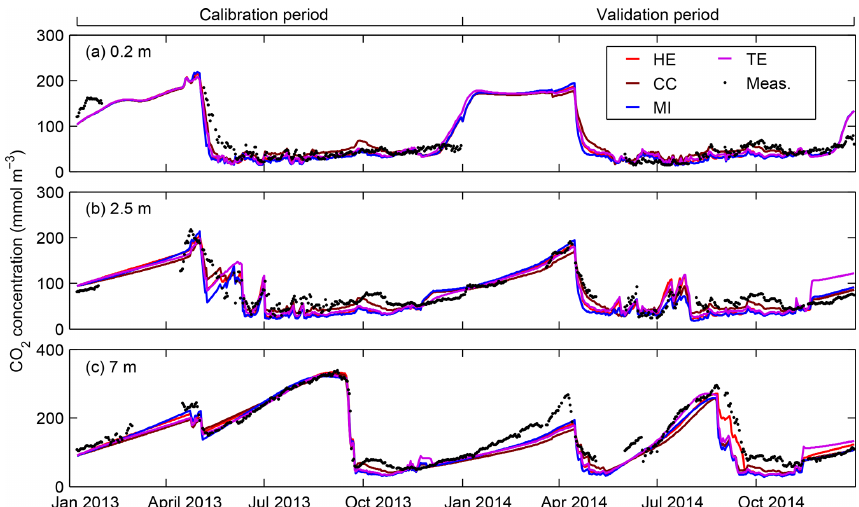
Figure 1. Simulation results for CO 2 concentration with each GEM (mmolm − 3 ) versus the daily averages of automatic high-frequency CO 2 concentration measurements at the depths of (a) 0.2m, (b) 2.5m, and (c) 7.0m in Lake Kuivajärvi during the calibration year 2013 and the validation year